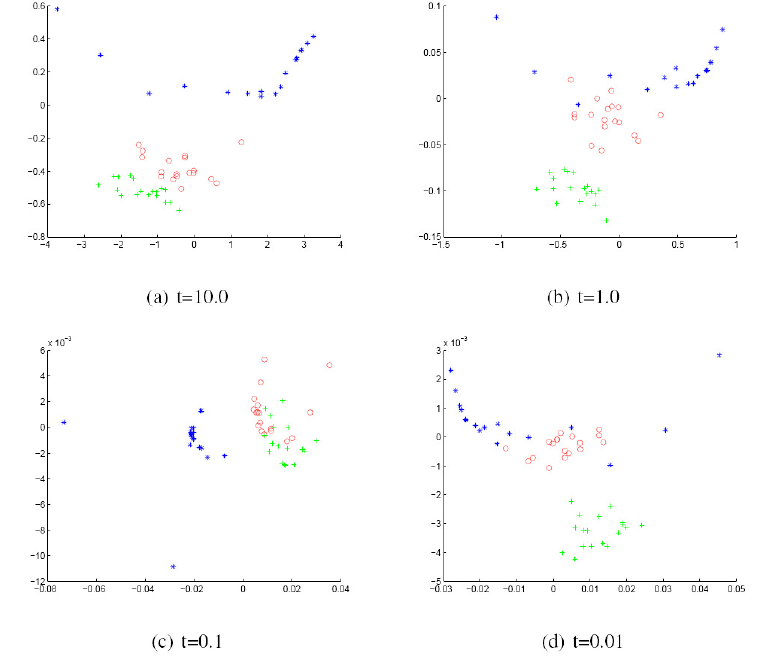
Figure 8. MDS embedding obtained using MHD for COIL data represented by the sectional curvatures residing on the edges. The x and y axes are the embedding coordinates corresponding to the leading two dimensions of the MDS embedding. The differently-coloured symbols denote different object classes.